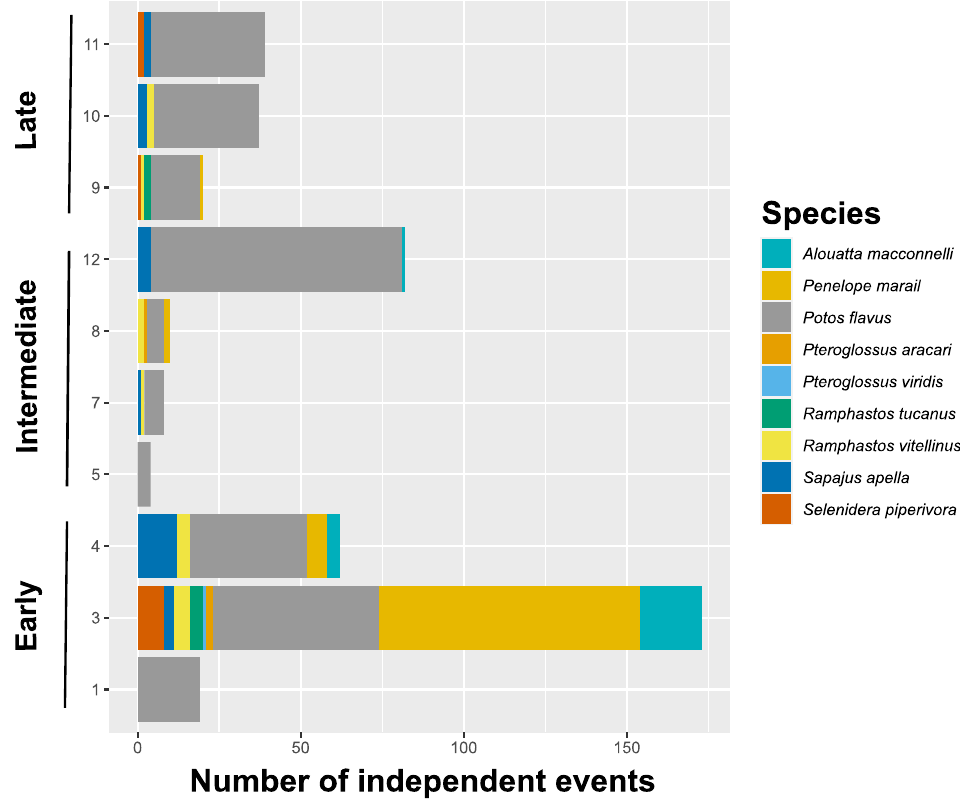
Figure 2. Number of independent events by tree for the nine main frugivores recorded as visiting the canopy of nutmeg trees between 12/01/19 and 01/24/20 in National 2 Road in French Guiana. Trees were grouped by their fruiting statues, either “early”, “intermediate”, or “late”. Trees 2 and 6 are not represented because no frugivores were recorded in their